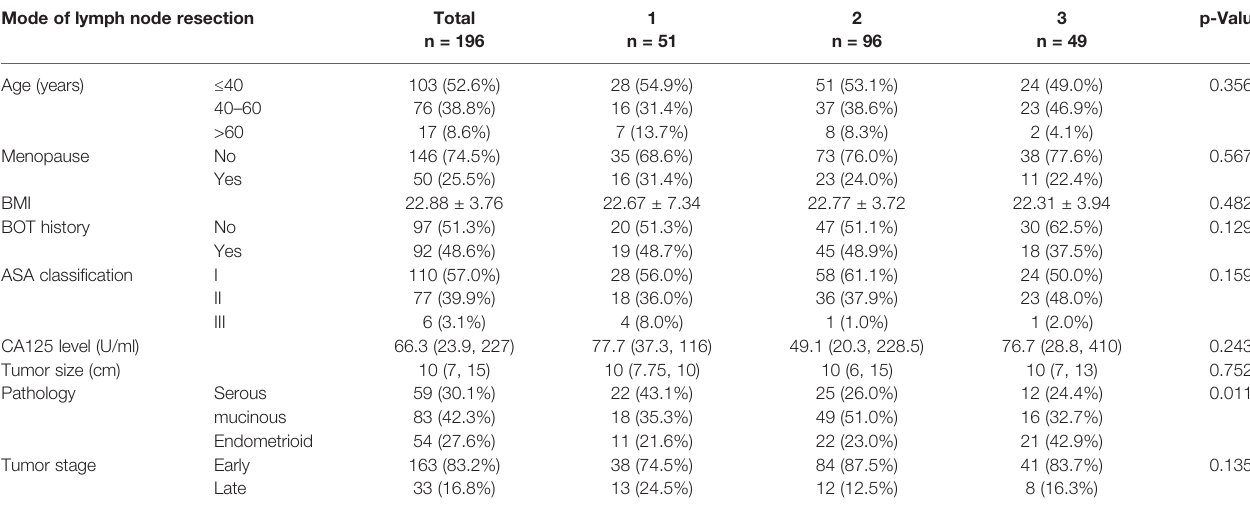
TABLE 1 | Clinical information of apparent early-stage patients with different LN resection methods. Mode of lymph node